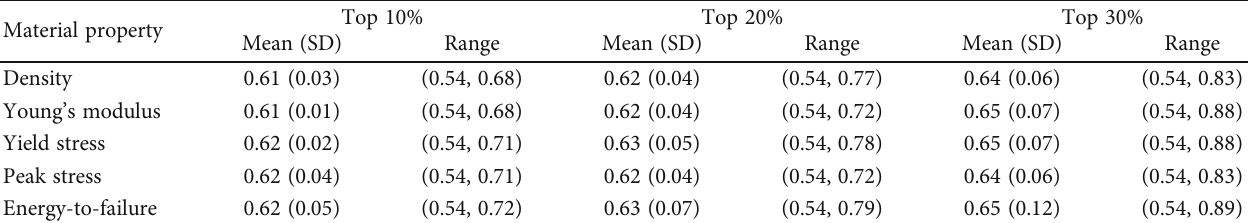
Table 2: Statistical characteristics of organic-inorganic phase ratio in groups of specimens having top material quality. Material